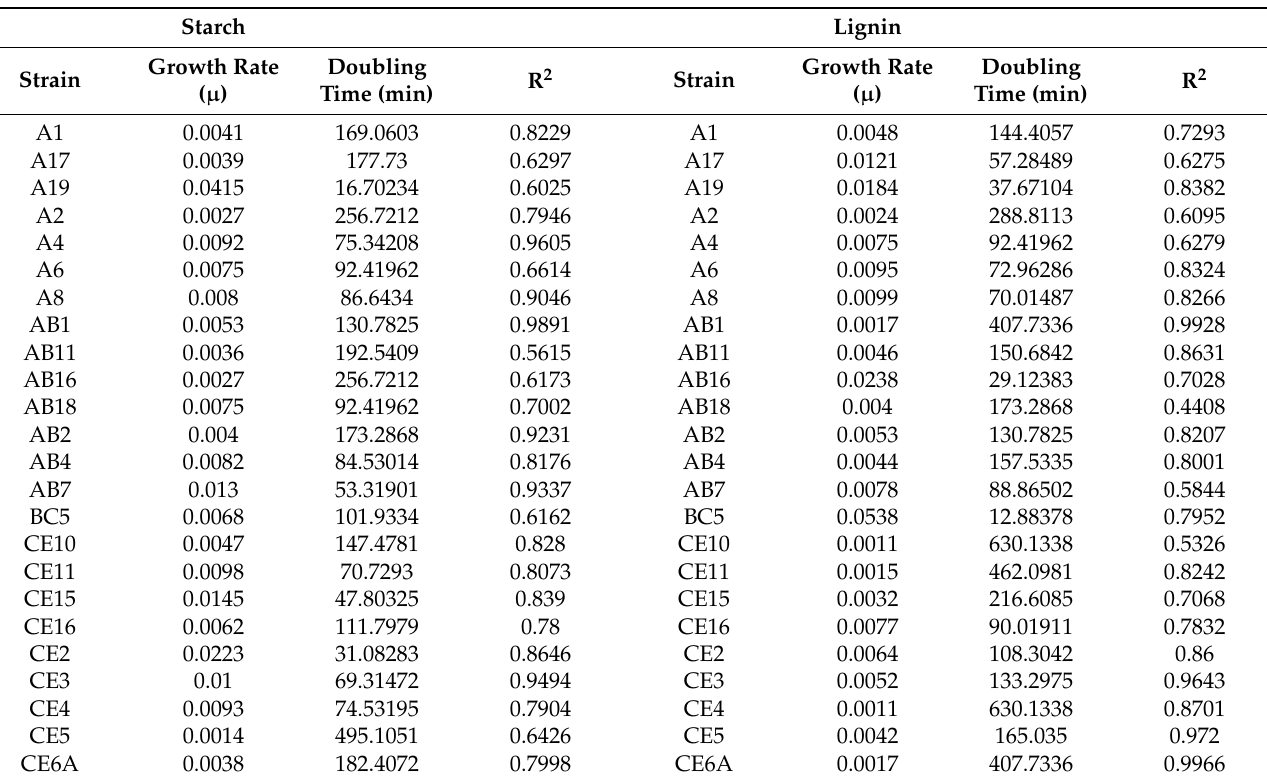
Figure 3. Slope of the growth curve showing the maximum growth rate of a typical bacterial isolate from the experiment. Table 3. Results of kinetic studies showing growth rate and doubling